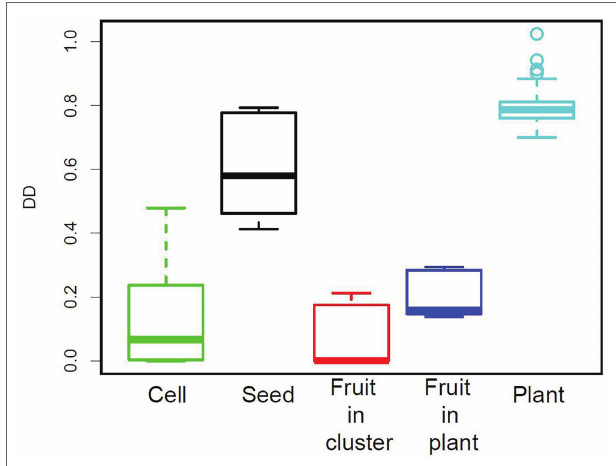
FIGURE 8 | Density-dependence index (DD) for the five levels of organisation